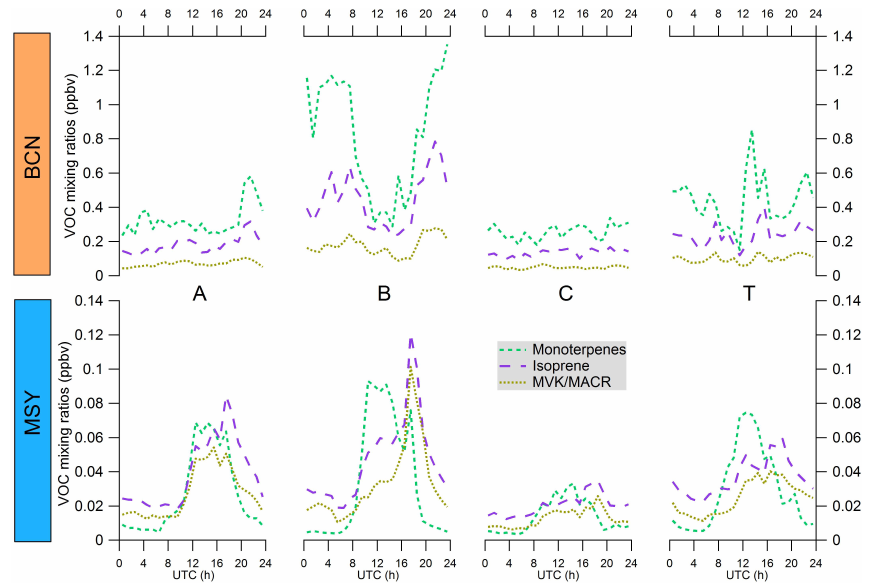
Fig. 6. Average isoprenoid VOC (and MVK/MACR) mixing ratios for each atmospheric scenario at BCN (top panels) and MSY (bottom panels). Note the different scaling between top and bottom panels (one order of magnitude).